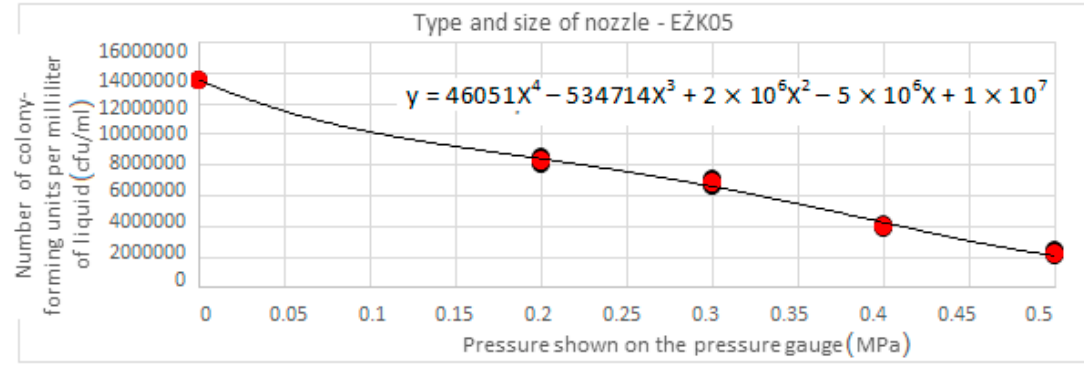
Figure 6. The influence of pressure on survival of cfu/mL of liquid for E Ż K05.